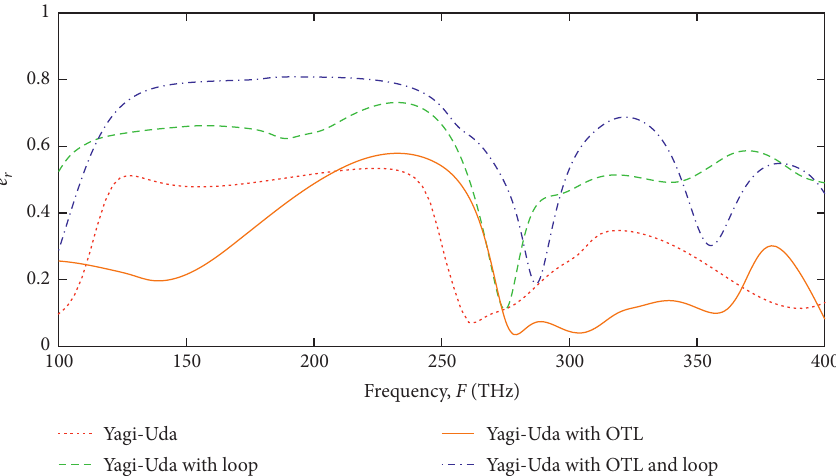
Figure 5: Radiation efficiency e r of the four optimized YU